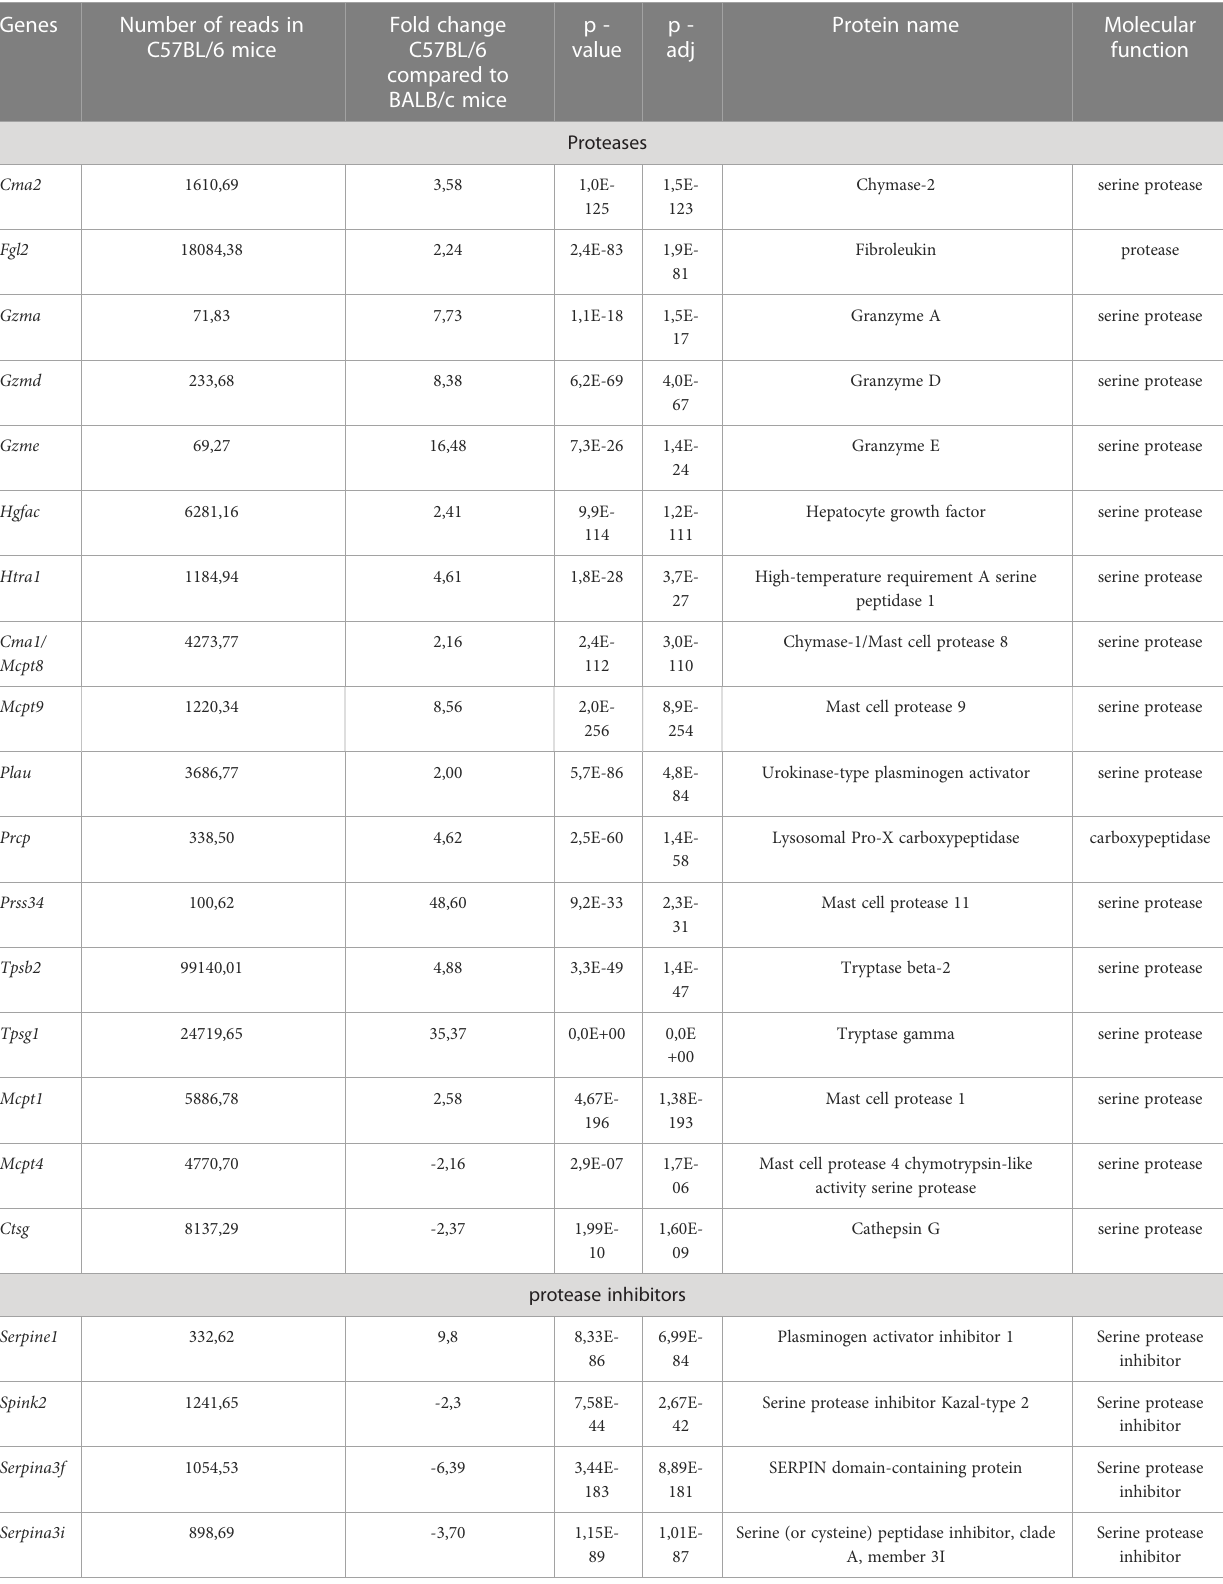
TABLE 1 List of selected genes differentially expressed by RNAseq analysis in three biological replicates of in vitro differentiated mast cells from C57BL/6 as compared to